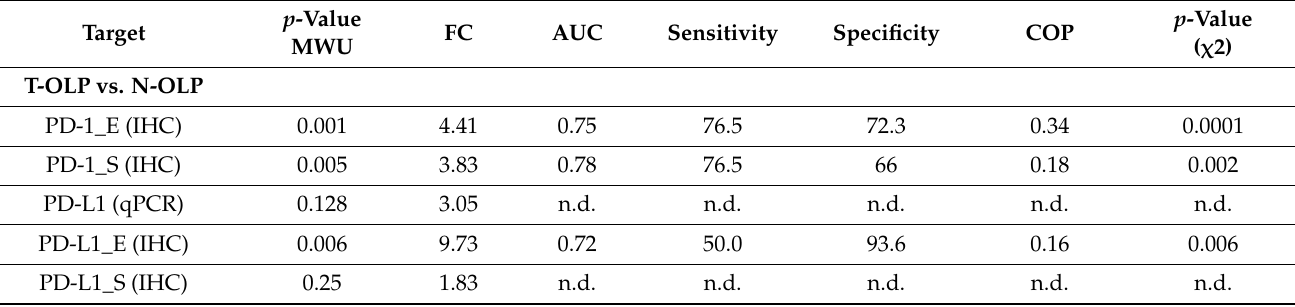
Table 5. Statistical results of the comparison of PD-1 and PD-L1 Expression between NOM and T-OLP, N-OLP and OSCC.